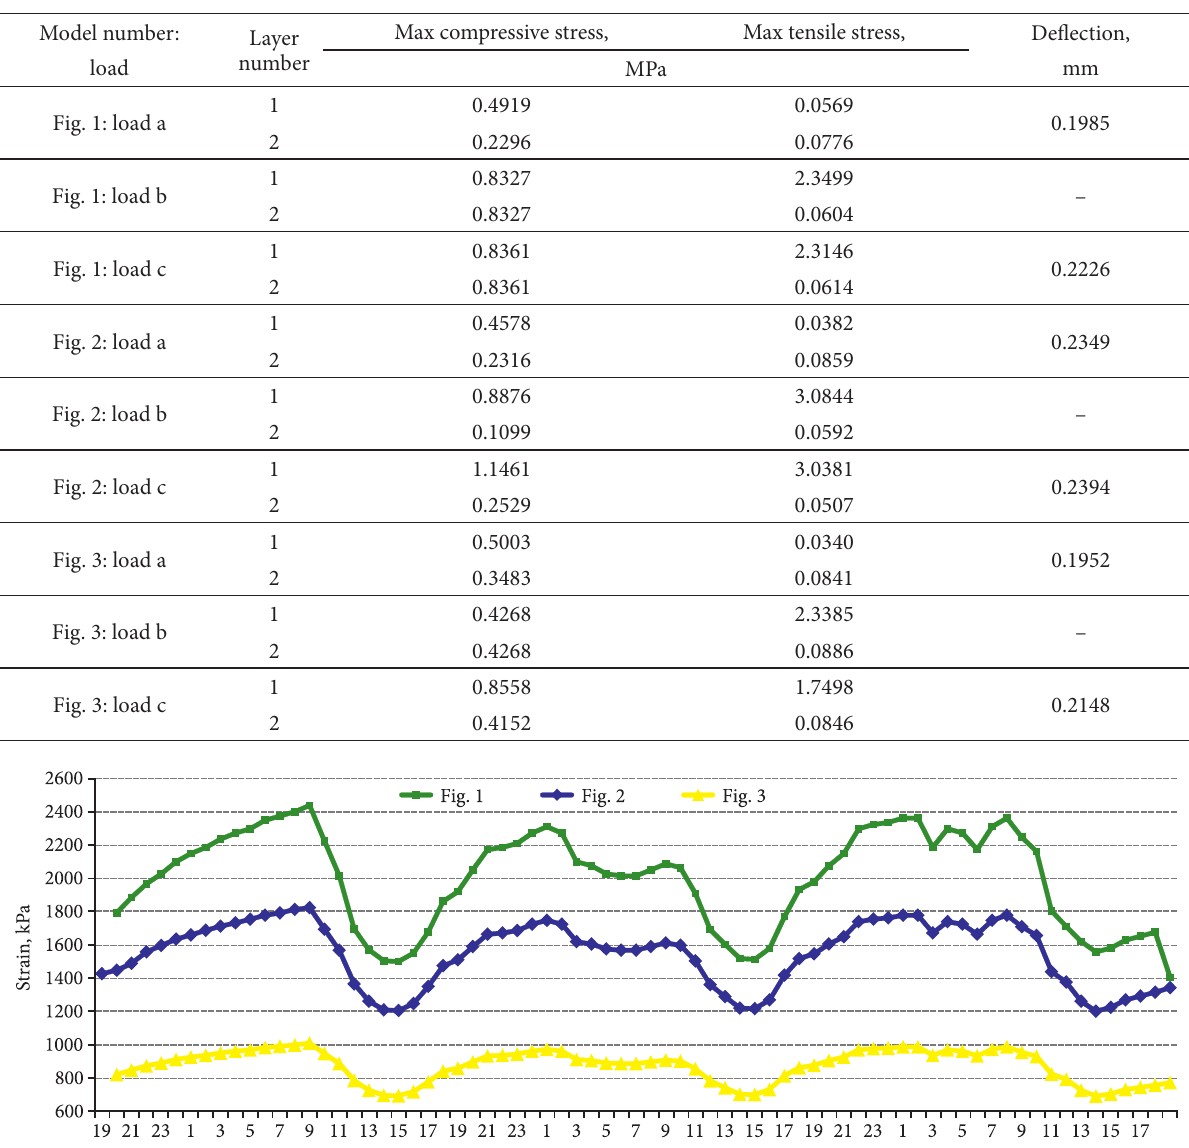
Fig. 15. Mode of deformation for the upper asphalt concrete layer – stresses during the days with max negative temperatures (schemes in Figs 1–4)